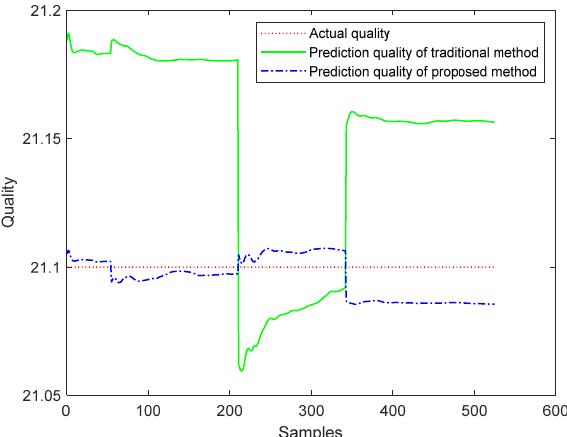
( b ) SPE statistics monitoring Figure 6. Single-mode online monitoring of packing-holding phase of mode 3. In addition, batches from mode 1 are tested using the monitoring model built based on mode 3; that is, the first 18 batches of mode 3 are selected for modeling, and 5 batches of mode 1 are tested. The results of each phase of one batch of five test batches in mode 1 are displayed. The quality prediction result is shown in Figure 7 and compared with that of the traditional partial least squares method. The mean RMSE predicted for the five test batches under different prediction methods are shown in Table 3. The mean RMSE pre- dicted by the traditional method is 0.1398, while the mean RMSE predicted by the pro- posed method is 0.1154, which indicates that the proposed recursive method of phase re- siduals shows a more accurate prediction effect. The monitoring results of the injection phase of mode 1 are shown in Figure 8. It can be seen that T 2 statistics do not exceed the control limit, but SPE statistics have exceeded the limit. The monitoring results of mode 1 in the packing-holding phase are shown in Figure 9 . It can be seen that SPE statistics of